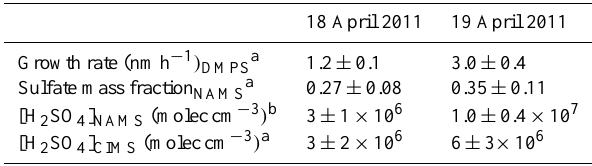
Table 1. Particle growth rate (measured over the period of growth from 10–20nm diameter), sulfate mass fraction (averaged over the period when the mode diameter was in the NAMS size range, ∼ 20nm diameter), calculated sulfuric acid concentration ([H 2 SO 4 ] NAMS , from Eq. 2) and measured sulfuric acid concentra- tion ([H 2 SO 4 ] CIMS , averaged over the period of growth from 10– 20nm) for particle formation events on 18 and 19 April